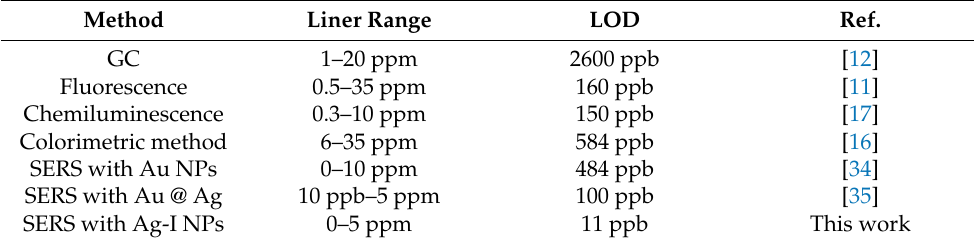
Table 1. Comparison of Different Methods for DM